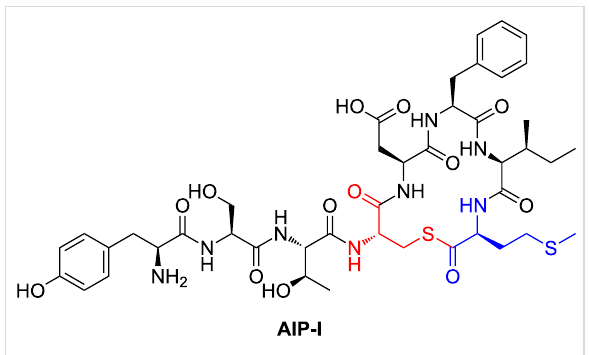
Figure 9: Structure of autoinducing peptide AIP-I from Staphylo- coccus aureus and the sequence of the corresponding precursor peptide